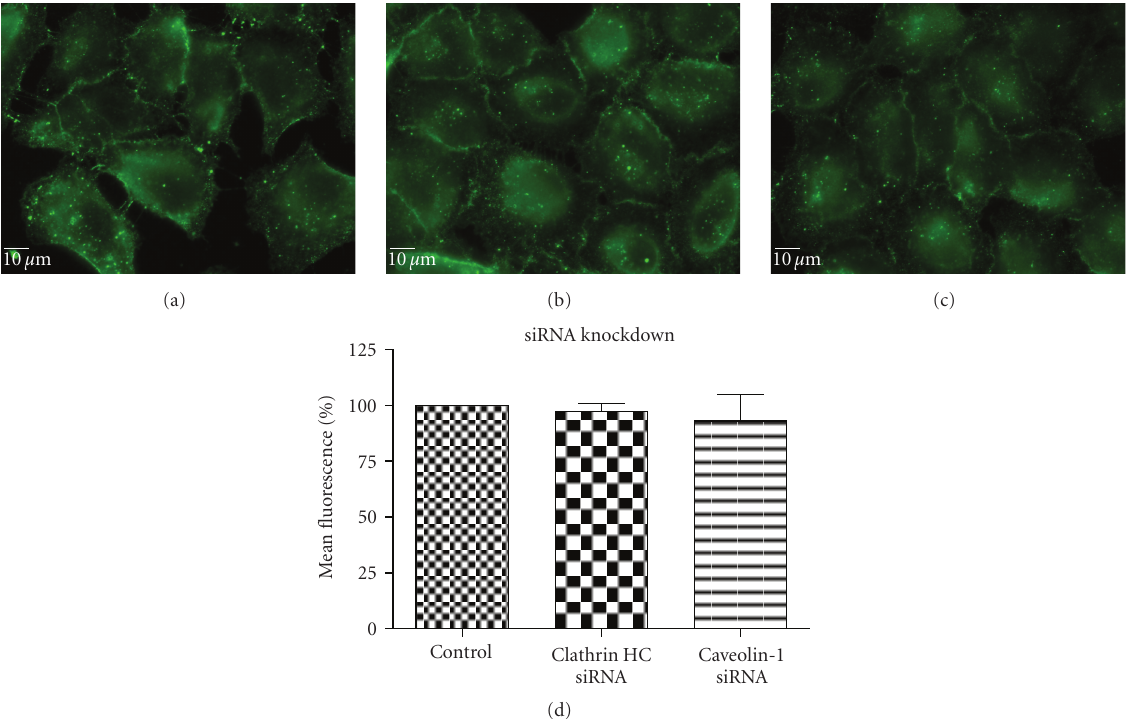
Figure 11: QD/SR9 uptake after knockdown of clathrin HC and caveolin-1 protein (150nM; 1 :20; 1 hour). A549 cells were treated with siRNA of clathrin HC or caveolin-1 protein for 3 days, and then cells were used for uptake studies. (a) Control cells. (b) Cells pretreated with clathrin HC siRNA. (c) Cells pretreated with caveolin-1 siRNA. Images are from a single plane of Z series. (d) Fluorescence intensity. Values are mean ± SD from three independent